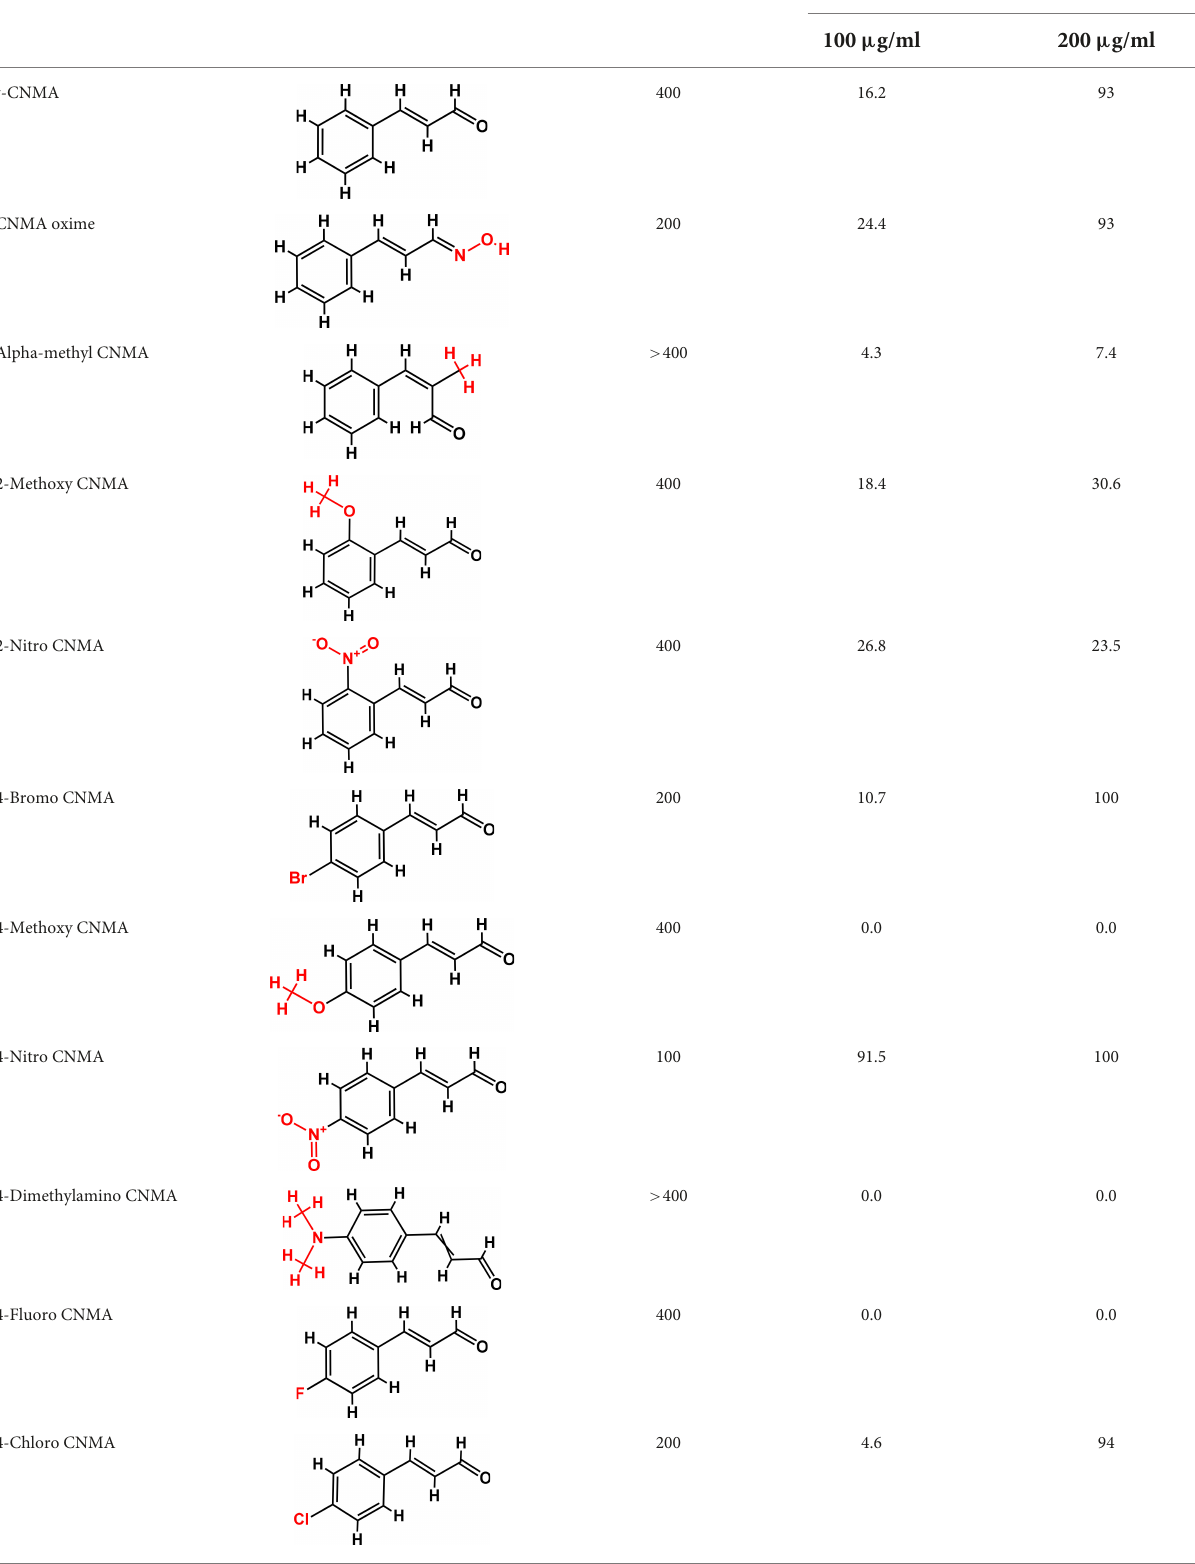
TABLE 1 Minimum inhibitory concentration and biofilm reduction by t -CNMA derivatives against A. tumefaciens